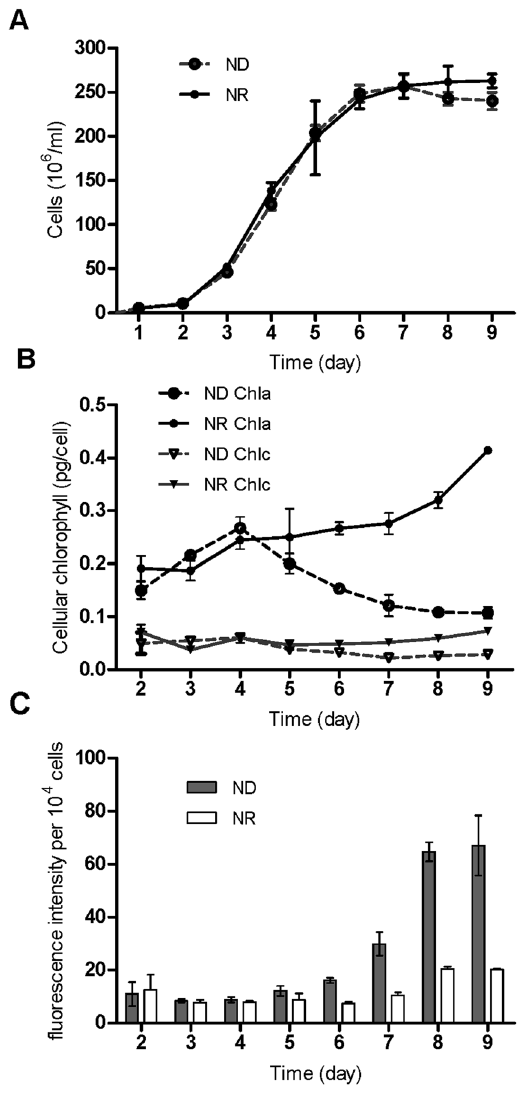
Figure 1. Physiological parameters of T. pseudonana under different N levels. The entire cultivation period was 9 days. ( A ) Growth of algal cells under N-replete (NR) and N deprivation (ND) conditions. ( B ) T. pseudonana cellular chlorophyll content in NR and ND treatments. ( C ) Nile Red fluorescence intensity per 10 4 cells. The data are displayed as the means ± SD (n =